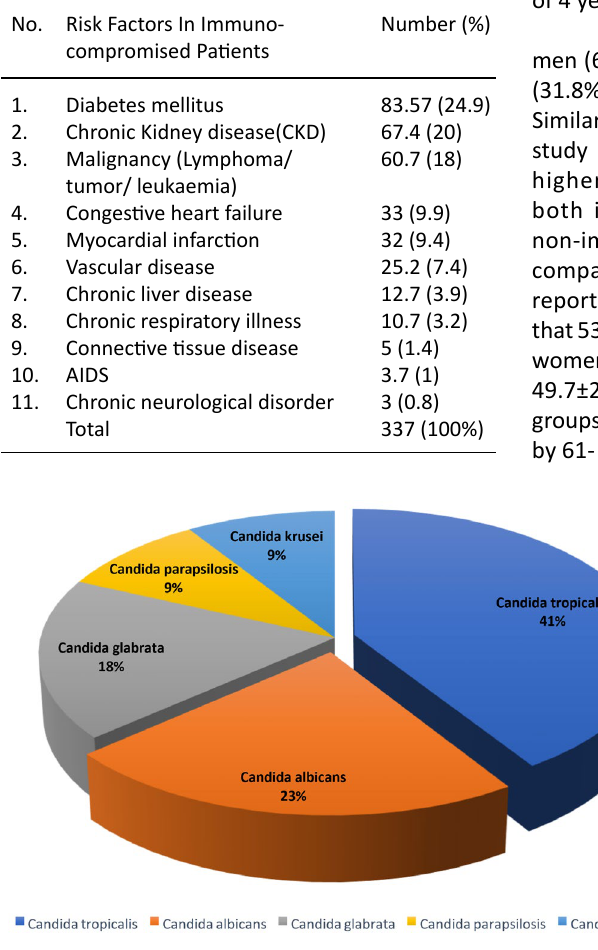
Fig. 2. Distribution of Candida species among (immunocompromised) patients